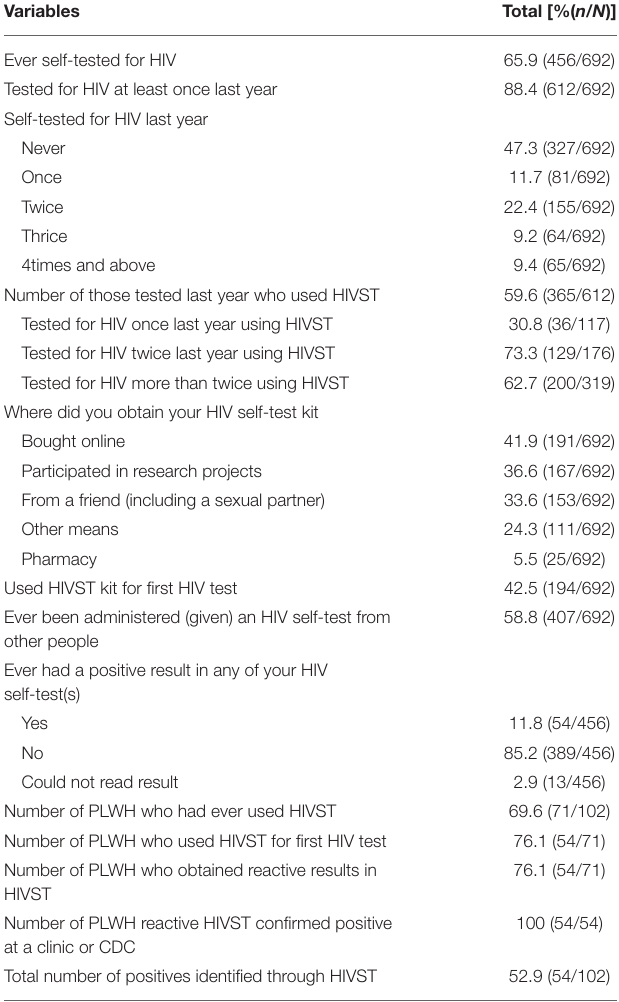
TABLE 2 | HIV self-testing experience among MSM in Jiangsu province, China, 2020.